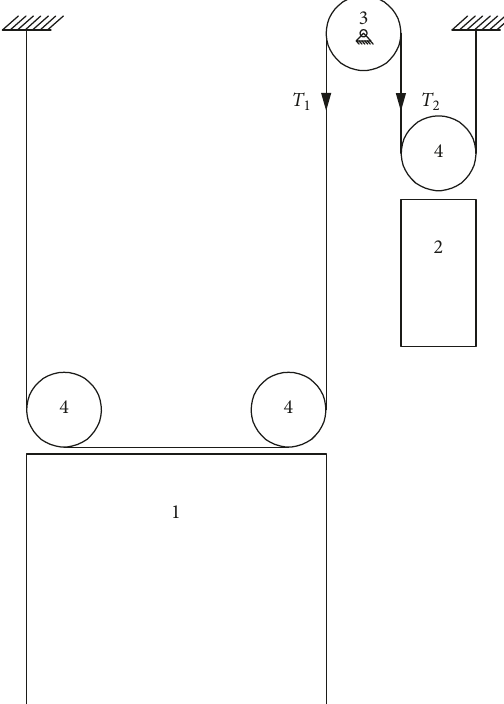
Figure 1: Diagram of traction system. (1) Car; (2)